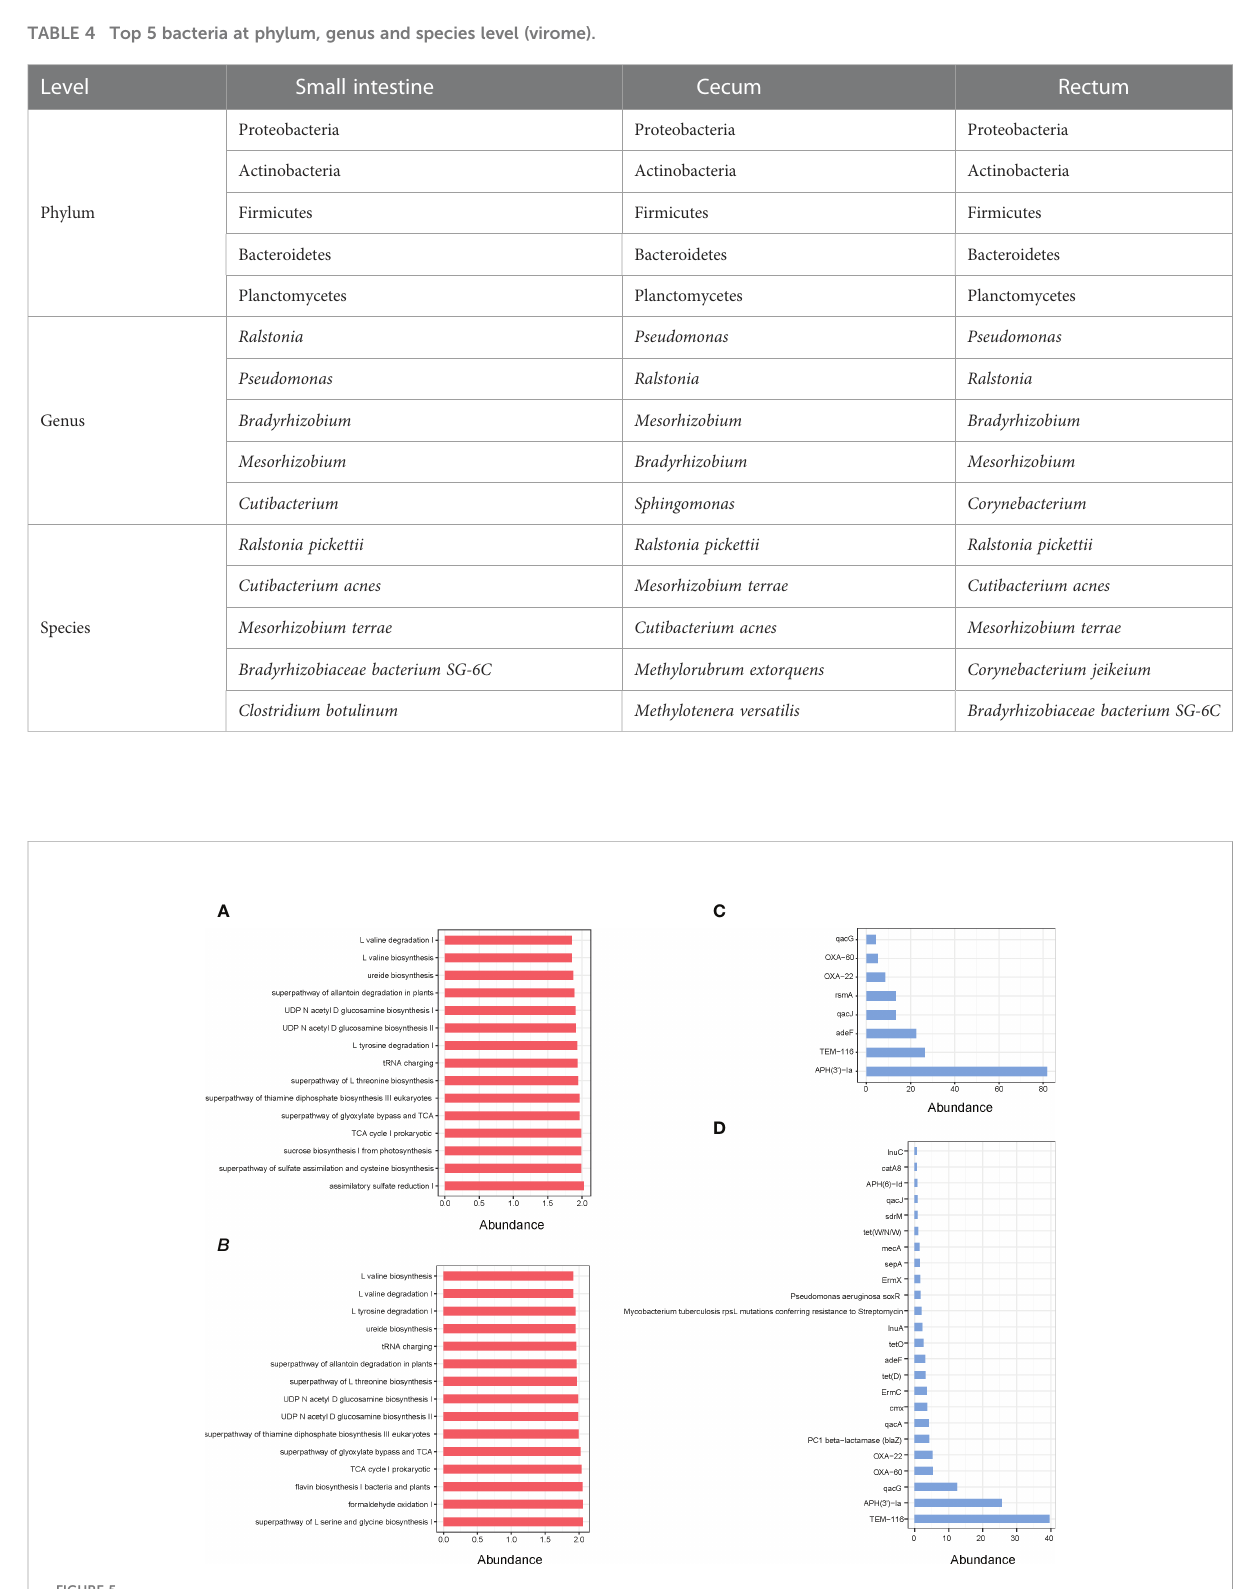
FIGURE 5 (A) Pathway enrichment analyses of small intestine microbiota. (B) Pathway enrichment analyses of rectum microbiota. (C) ARGs analysis of small intestine microbial. (D) ARGs analysis of rectum